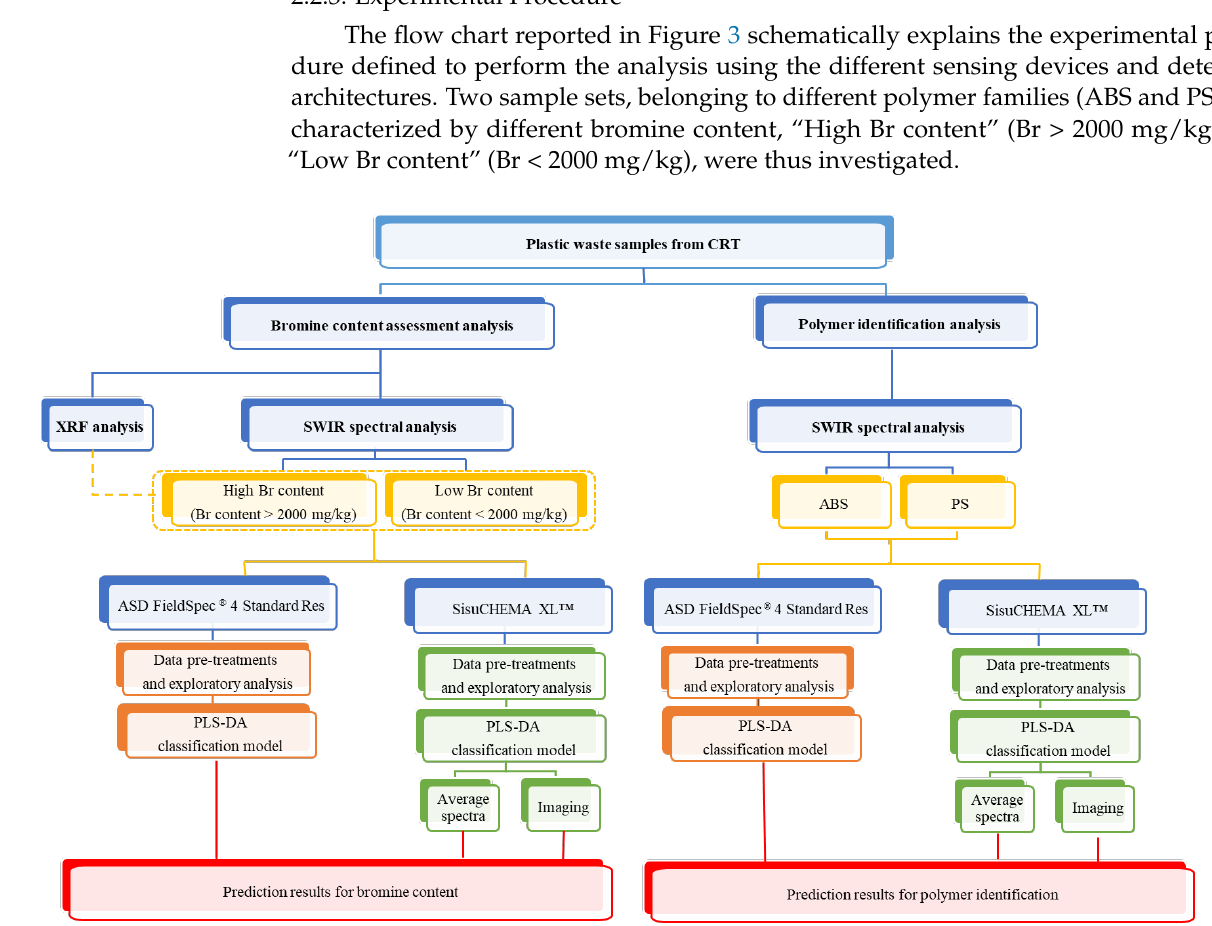
Figure 3. Flow chart adopted to perform the classification procedures for the identification of samples characterized by high and low bromine contents and the further recognition of ABS and PS scraps.